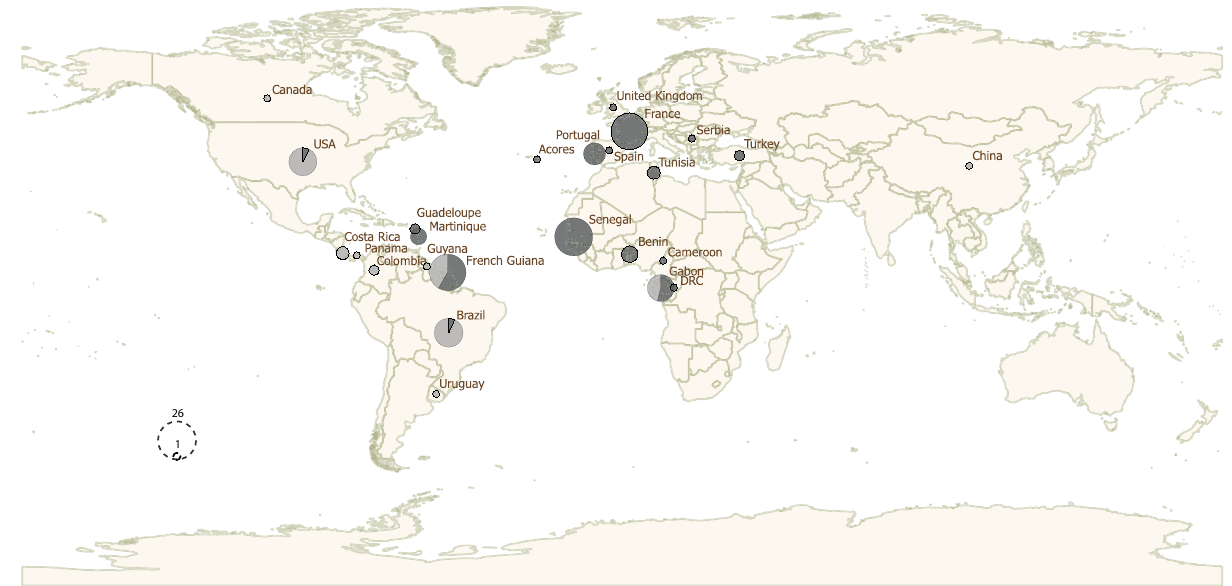
Fig. 1 | Thegeographical distributionof Toxoplasma gondii strainsanalysed in this study. Sizes of piecharts correlate with totalnumber of mono-strains isolates for each country. Isolates sequenced speci fi cally for this study are represented in dark grey and whole-genome sequence data from previous studies — publicly